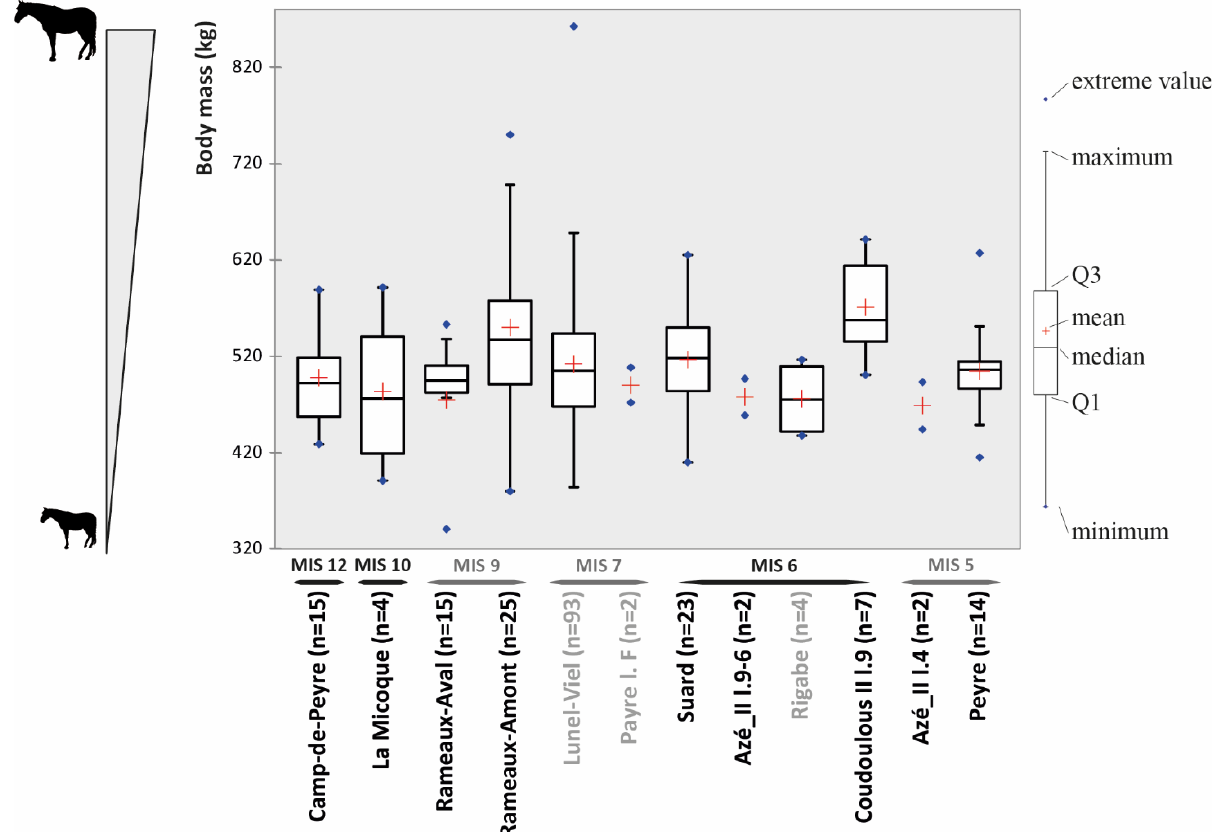
Figure 3. Box plot of the estimated weight in kilograms of Southern France Middle and Late Pleistocene caballoid horses based on metacarpal and metatarsal measurements (MC2, MC4, and MC6, MT2, MT4 and MT6 of Scott [79]). Camp-de-Peyre: E. m. campdepeyri ; La Micoque: E. mosbachensis ; Rameaux-Aval and Amont: E. mosbachensis ; Lunel-Viel: E. m. palustris ; Payre l.F: E. mosbachensis ; Suard: E. caballus piveteaui ; Pech de l’Az é II l.9-6: E. mosbachensis ; Rigabe: E. m. palustris ; Coudoulous II l.9: E. mosbachensis ; Pech de l’Az é II l.4: E. caballus ; Peyre: E. caballus . Vertically: in grey, South East sites, in black South West sites. Horizontally: in grey temperate isotopic stages, in black glacial isotopic